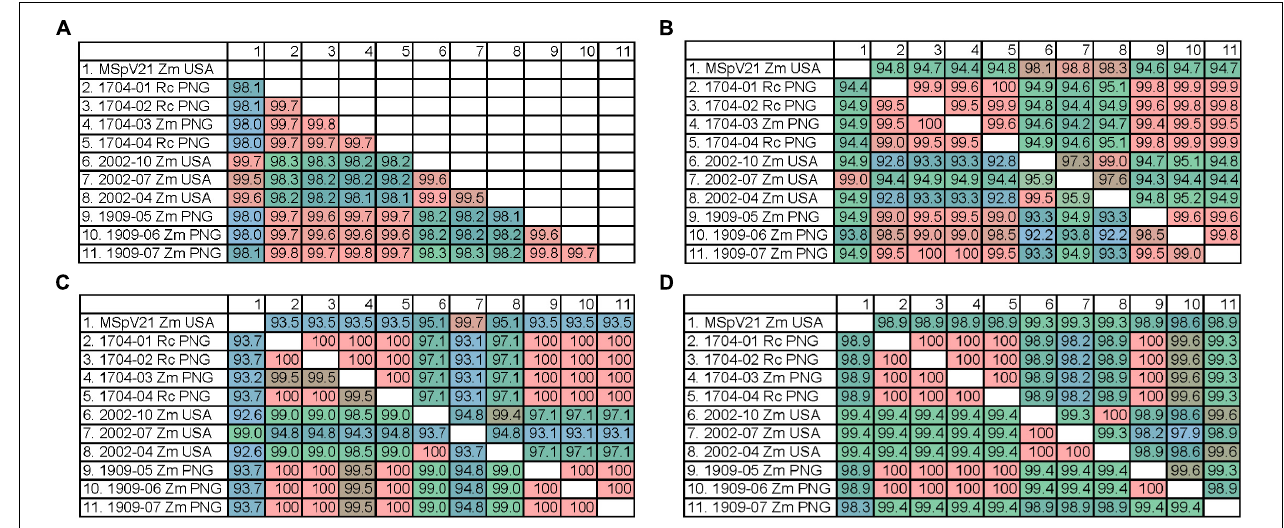
FIGURE 5 | Percent identity matrices of predicted protein sequences from each sequenced isolate of maize stripe virus. (A) pc1 from RNA1; (B) p2 (bottom) and pc2 (top) from RNA2; (C) p3 (bottom) and pc3 (top) from RNA3; (D) p4 (bottom) and pc4 (top) from RNA4. Rc, Rottboellia cochinchinensis ; Zm, Zea mays ; PNG, Papua New Guinea; USA, United States of